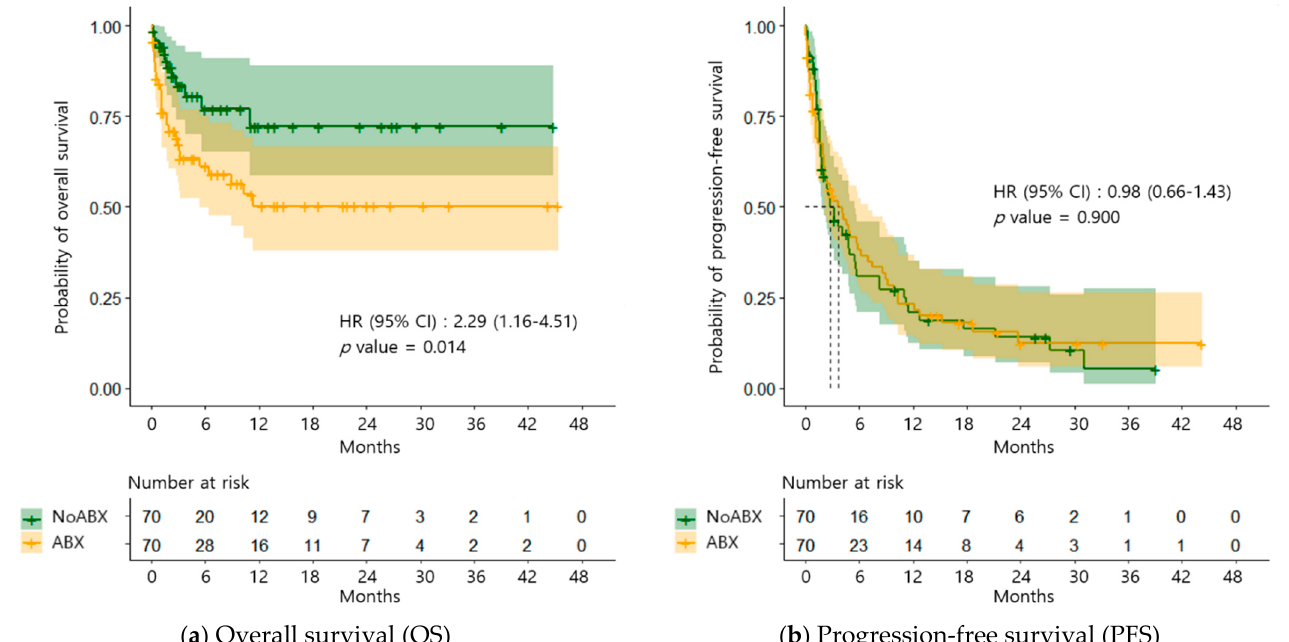
Figure 2. Kaplan-Meier survival plots for overall survival ( a ) and progression-free survival ( b ) in both patients who treated with nivolumab for non-small cell lung cancer with antibiotics (ABX group, n = 70) or without antibiotics (NoABX group, n =